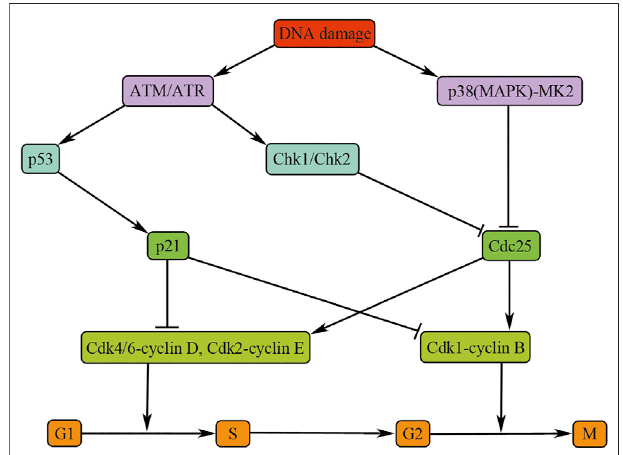
FIGURE2| CellcycleregulationafterDNAdamage.The fi gureillustrates the pathways and molecules that regulate the cell cycle upon DNA damage. Inhibition of Cdk4/6-cyclin D and CDK2-cyclin E is essential for G1/S arrest and blocking CDK1-cyclin B is necessary for G2/M arrest. ATM, ataxia telangiectasia mutated; ATR, ataxia telangiectasia and Rad3-related; Chk, checkpoint kinase; Cdc25, cell division cycle 25; CDK, cyclin-dependent